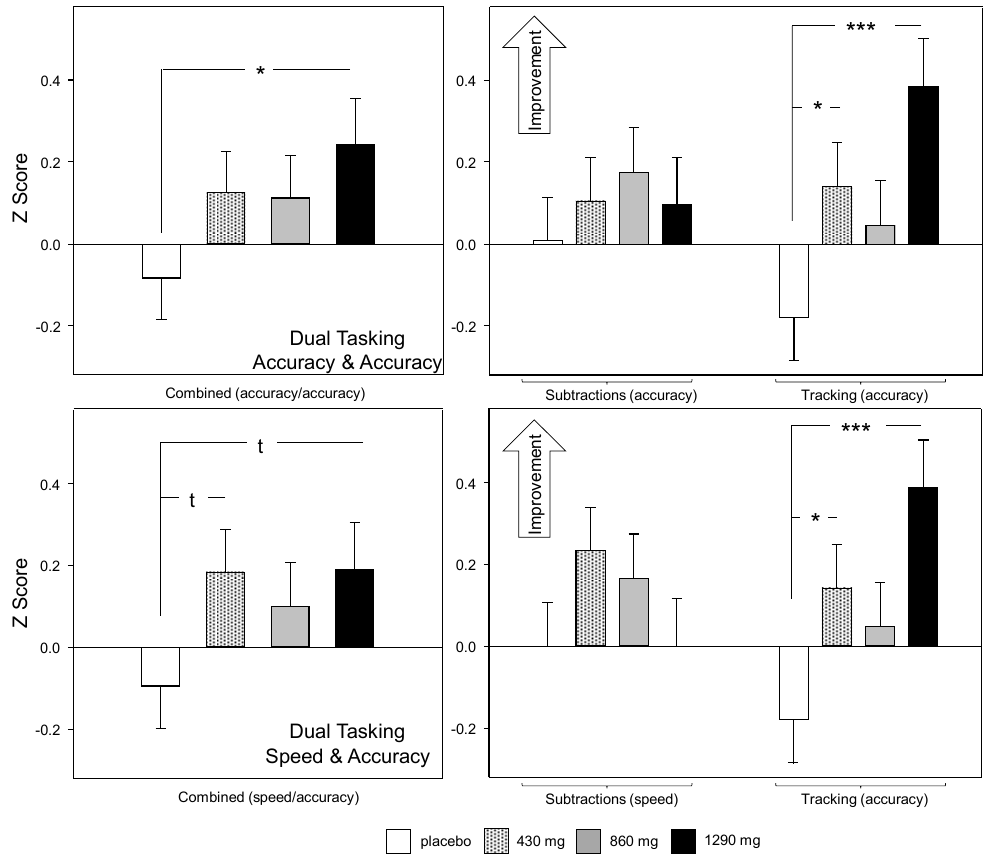
Figure 6. Chronic (Day 29) treatment related change in multitasking performance averaged across pre-dose, 2 h and 4 h post-dose assessments. Scores for each measure were converted into standardised Z score with a positive score indicating improved performance in order to analyse data together. Data shown are estimated means (plus SE) derived from the LMM analysis, using Day 1 pretreatment baseline data and age as covariates. The Z scores are plotted with an increased score indicating improved performance. The top panels show subtraction accuracy (errors) and tracking accuracy data; the bottom panels show subtraction speed (total number) and tracking accuracy data. In both top and bottom panels the left-hand panels show comparisons of mean Day 29 data averaged across the two concomitantly performed task outcomes (serial subtractions / tracking), and the right-hand panel shows comparisons conducted on the separate task outcomes. The data for tracking is the same in both analyses. t, p < 0.1, *, p < 0.05; ***, p < 0.001 in comparison to placebo.